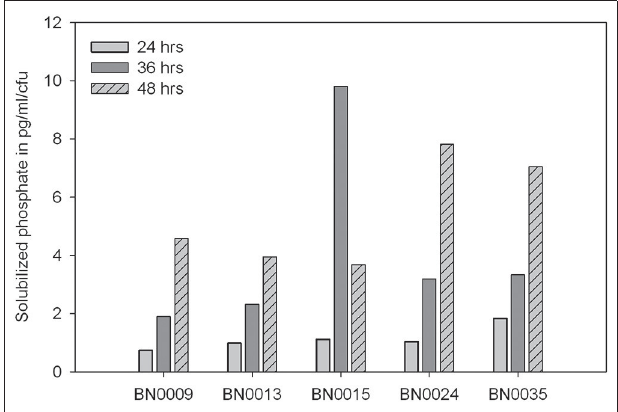
FIGURE 3 | Phosphate solubilization capacity per cell of the five selected phosphate-solubilizing bacteria at three different times of incubation.